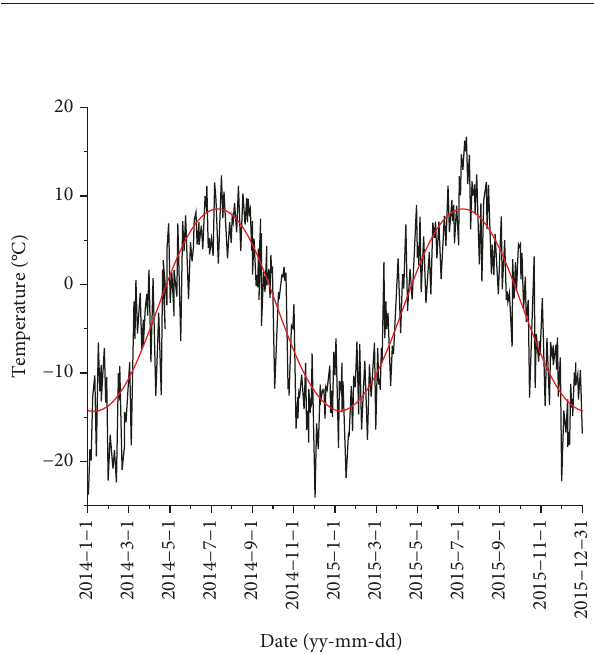
Figure 5: The temperature data of Y5854 weather station from 2014 to 2015.